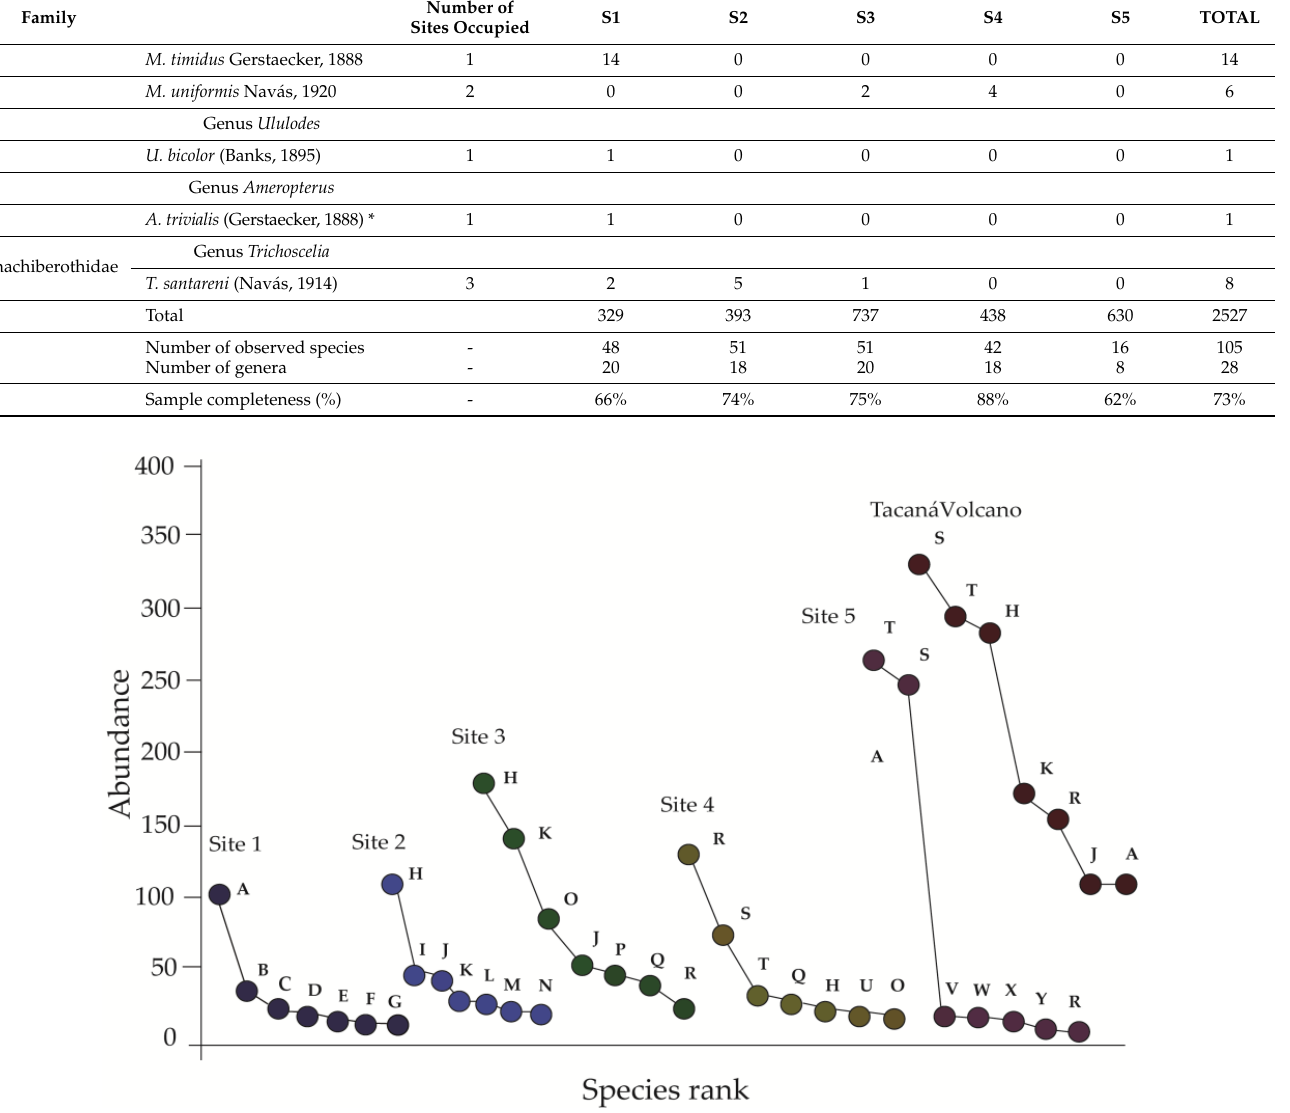
Figure 3. Rank-abundance curves of Neuroptera species for the different sampling sites and at